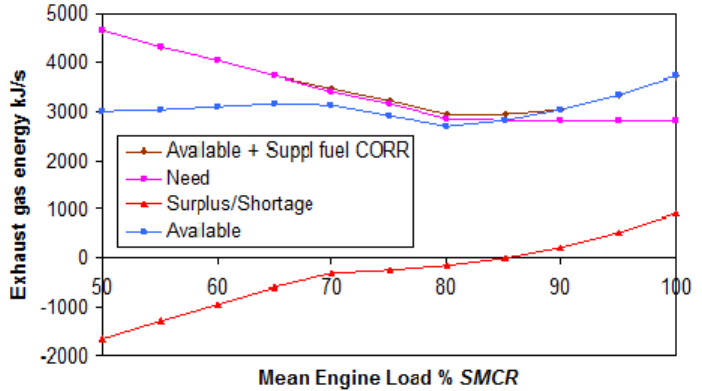
Figure 8. Exhaust gas energy and supplemental HFO at full electrical power for the R123 fluid.